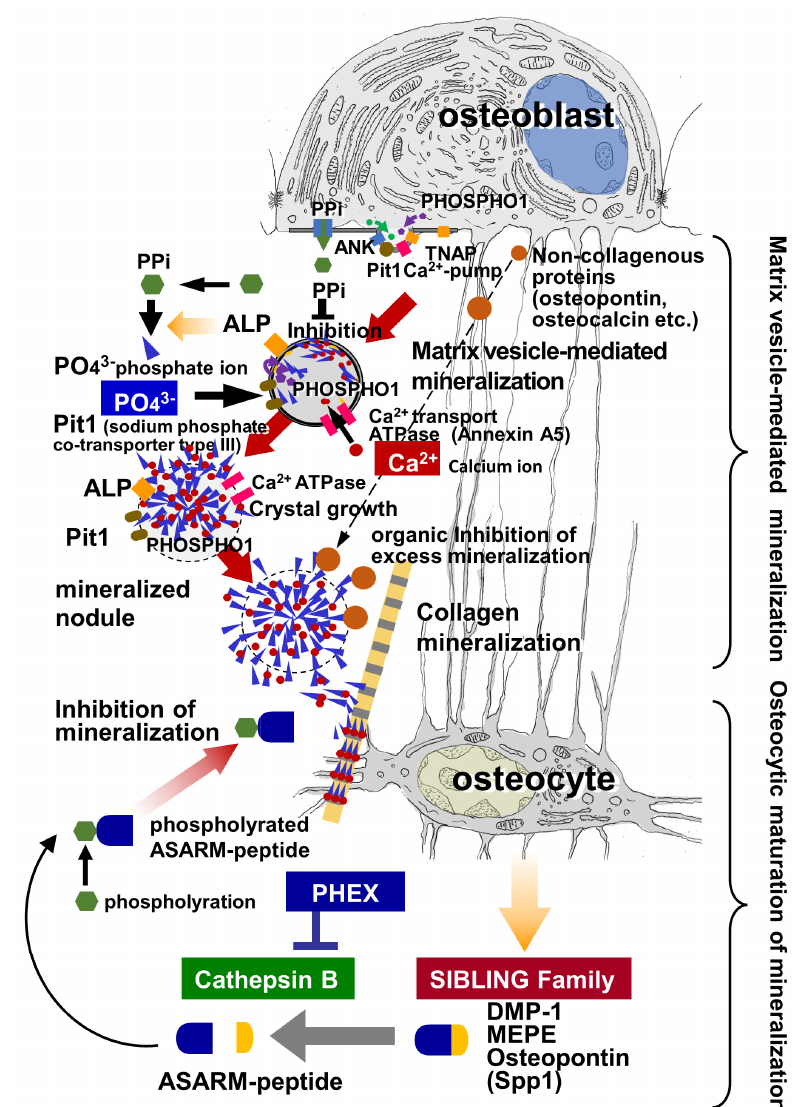
Figure 4. A schematic design of matrix vesicle-mediated mineralization and subsequent osteocytic maturation of mineralization.